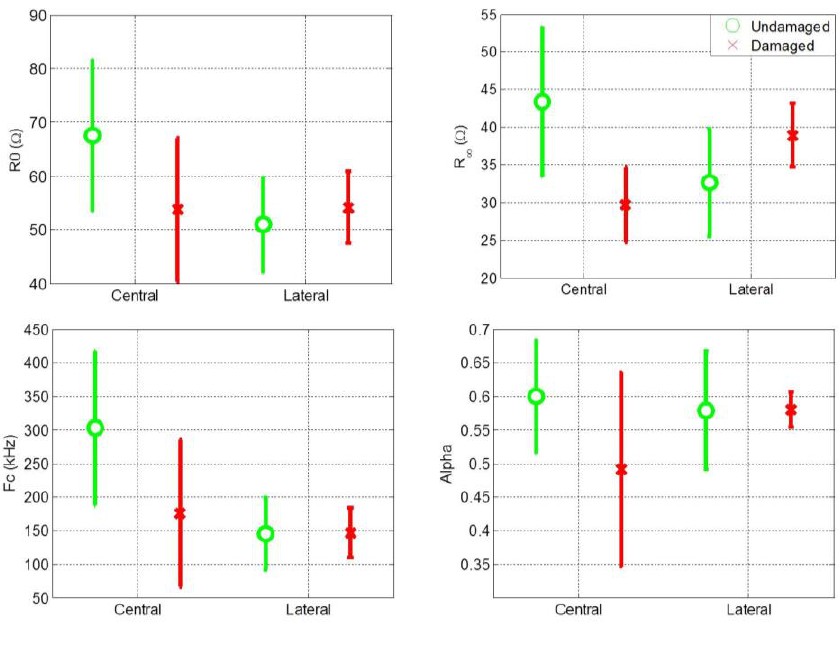
Figure 2. Mean and standard deviation of Cole parameters from all the EBIS measurements.